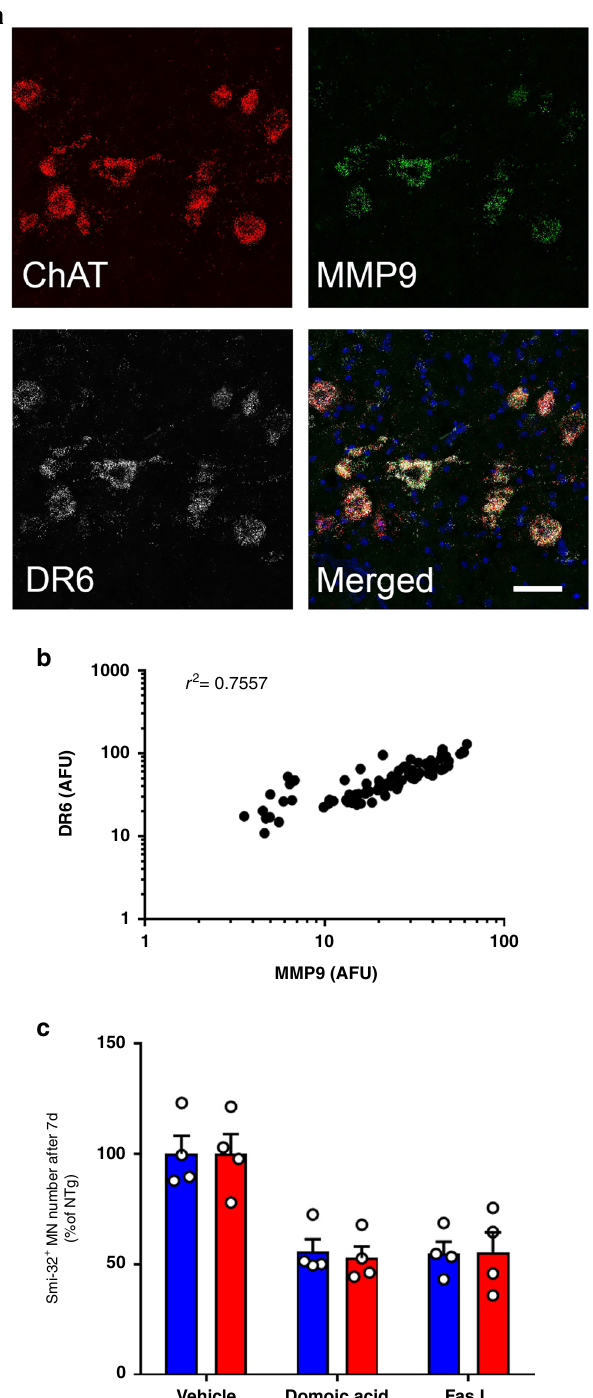
Fig. 6 MN toxicity susceptibility marker MMP9 positively correlates with DR6. a 20 μ m thick un fi xed L4/L5 sections of spinal cord from WT mice were labeled with fl uorescent probes for DR6, MMP9, and ChAT using RNAscope technique. Representative images are shown. Scale bar: 50 μ m. b Pearson ’ s linear correlation analysis was performed between DR6 and MMP9 in ChAT-positive MNs (r (75) = 0.8693, CI 0.8013 – 0.9151, two-tailed P < 0.0001). Similar r values were obtained for two additional independent experiments. Representative correlation plot of three experiments